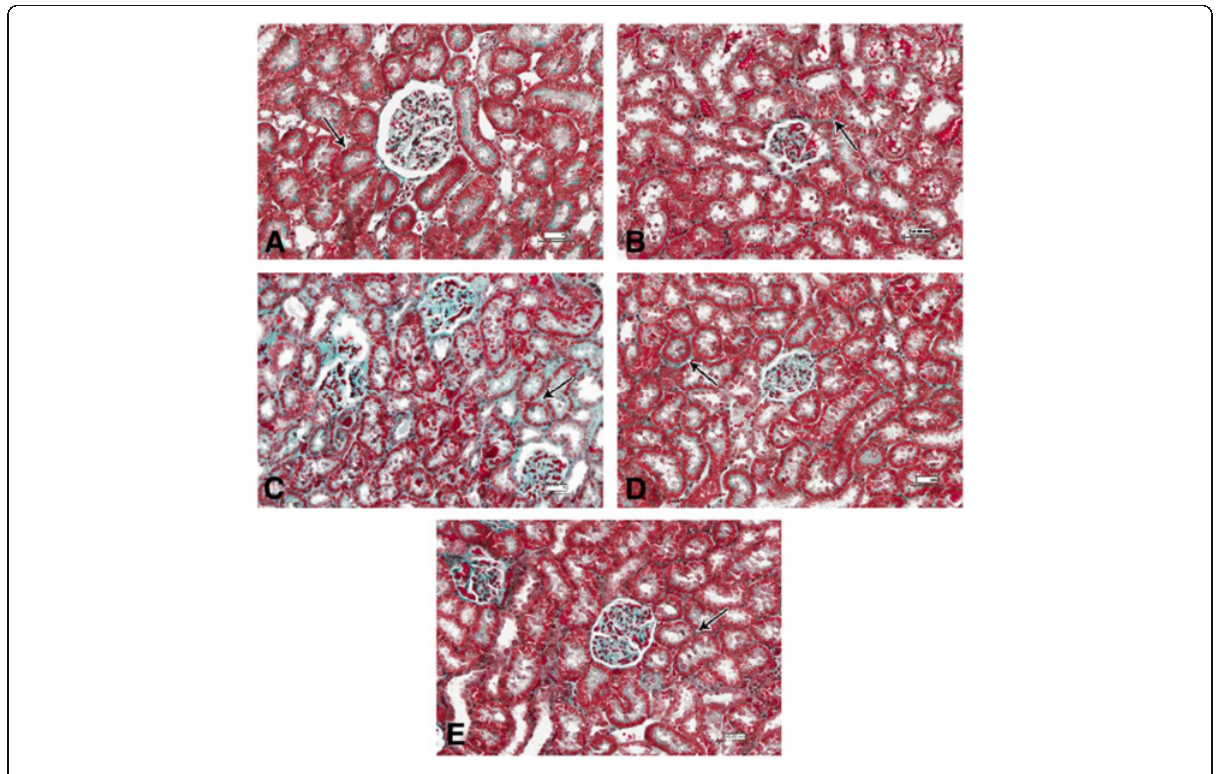
Figure 6 Photomicrographs of kidney sections stained with hematoxylin and eosin (scale bars=50 μ m), showing: (A) control group, normal renal corpuscles with normal glomeruli (arrow) and renal tubules (asterisks); (B) intoxicated group with 1 g/kg body weight/ day for 5 days with n-ZnO particles, shrinkage and fragmentation of many glomeruli (arrows). In addition many renal tubules show degeneration, necrosis (arrowheads) and exfoliation of their lining epithelium (curved arrow). (C) Qur-treated group, many glomeruli reveal shrinkage and fragmentation (arrows) with degeneration, necrosis (arrowheads) and exfoliation of epithelial lining cells of the renal tubules (curved arrow). (D) Arg-treated group: Almost all the renal corpuscles with their glomeruli (arrows) as well as the renal tubules (asterisks) are similar to normal architecture. (E) Qur+Arg-treated group, there were few renal tubules with degeneration, necrosis (arrowhead) and exfoliation of their lining epithelial cells (curved